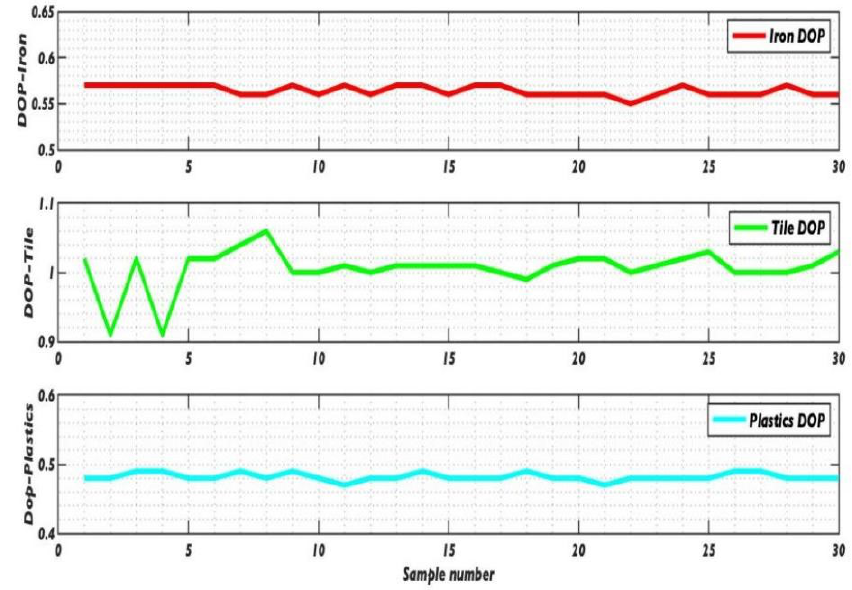
Figure 8. A comparison of the degree of polarization of different objects in the air.